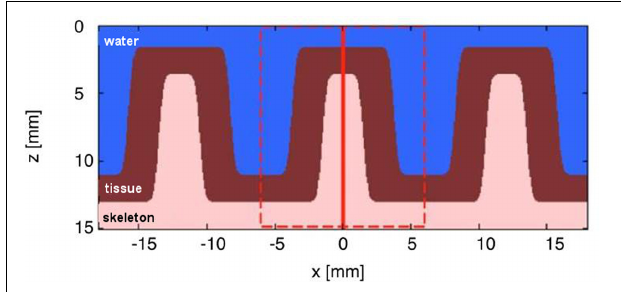
FIGURE 1 | Simplified structural 2-layer model of a faviid coral in x , z dimensions. The model assumes the dimensions of a massive faviid coral with ∼ 3 mm thick skeletal walls (i.e., the coenosteum), ∼ 10 mm wide corallites and a ∼ 2 mm thick living tissue layer. The model extends uniformly along y and shows three layers: water, living tissue, and skeleton. The dashed red line indicates the region modeled by the Monte Carlo simulation. The vertical solid red line indicates the position of light delivery to the top of the skeleton/tissue